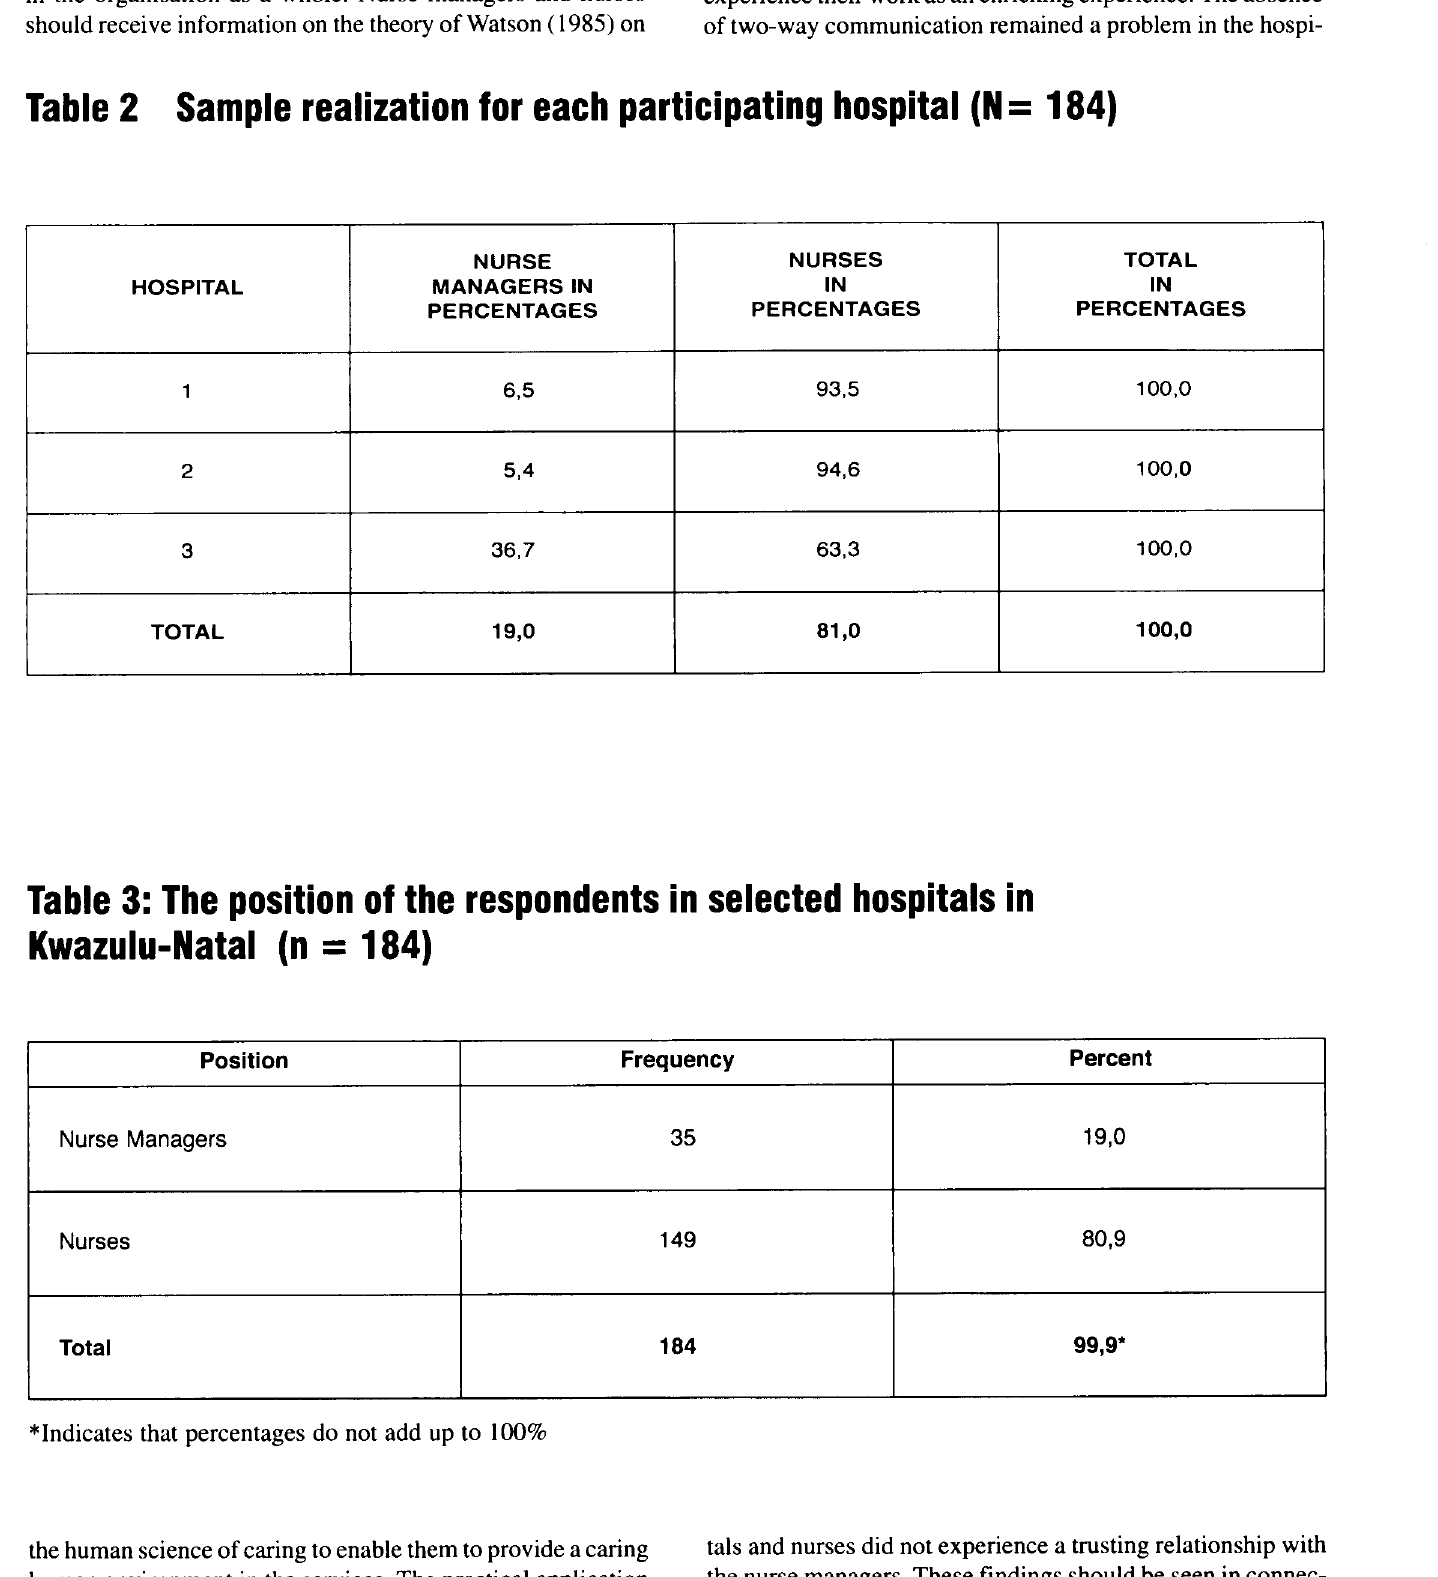
Sample realization for each participating hospital (N = 184)